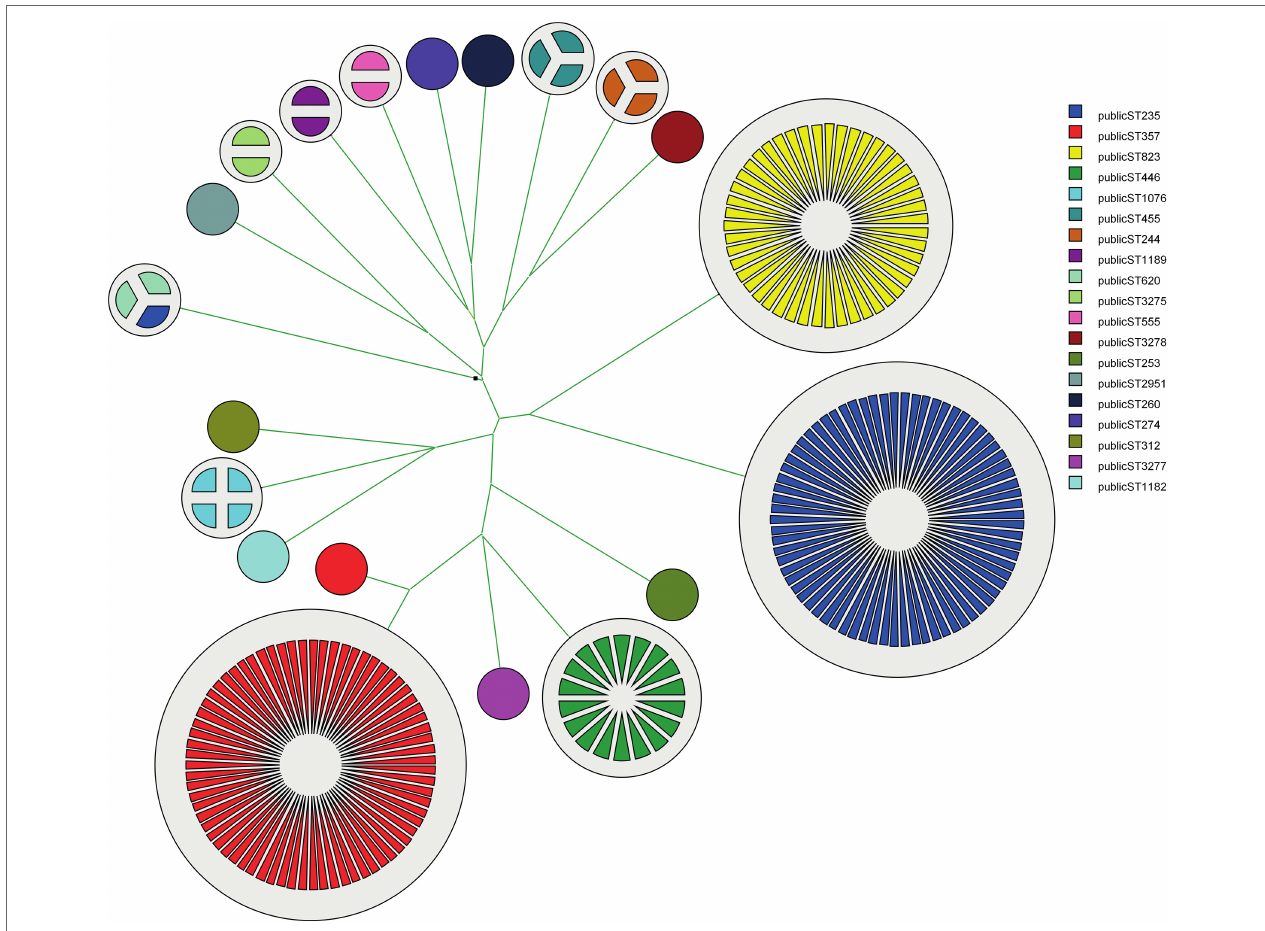
FIGURE 1 | Classical MLST-based phylogenetic tree showing the evolutionary relationship between different CNPA sequence types (ST), each indicated by a different a color and provided with its ST number. Number of partitions in each cluster showing the number of strains in that group. Note that ST357, ST823 and ST235 represent the largest clonal clusters. A similar illustration was presented by Pelegrin et al.